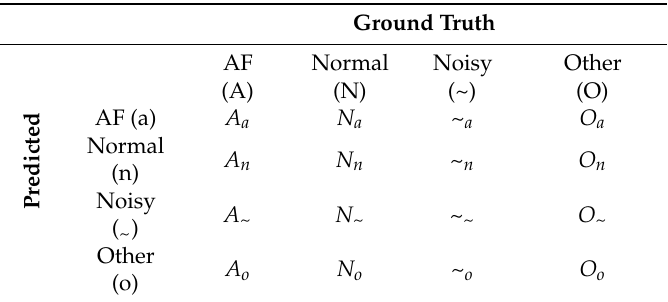
Table 2. Confusion matrix of four classes.